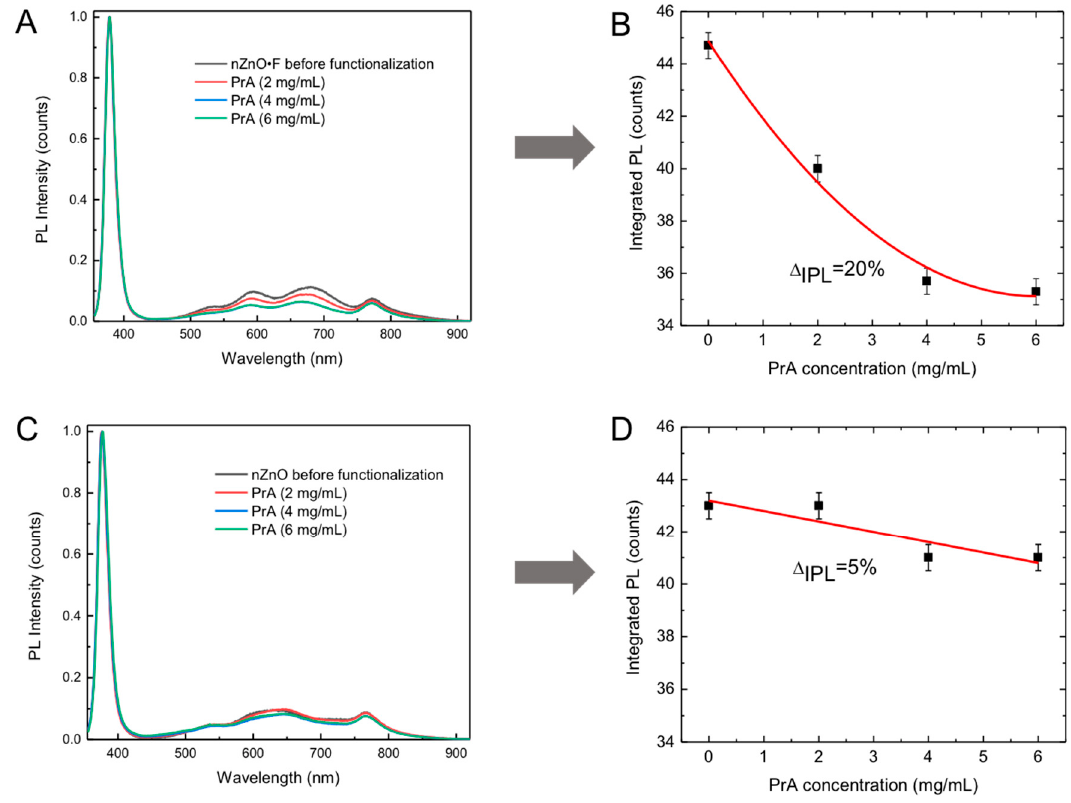
Figure 6. PL spectra of nZnO·F ( A ) and nZnO ( C ) measured after incubation with different concentrations of PrA; corresponding values of integrated PL as function of PrA concentration ( B , D ).